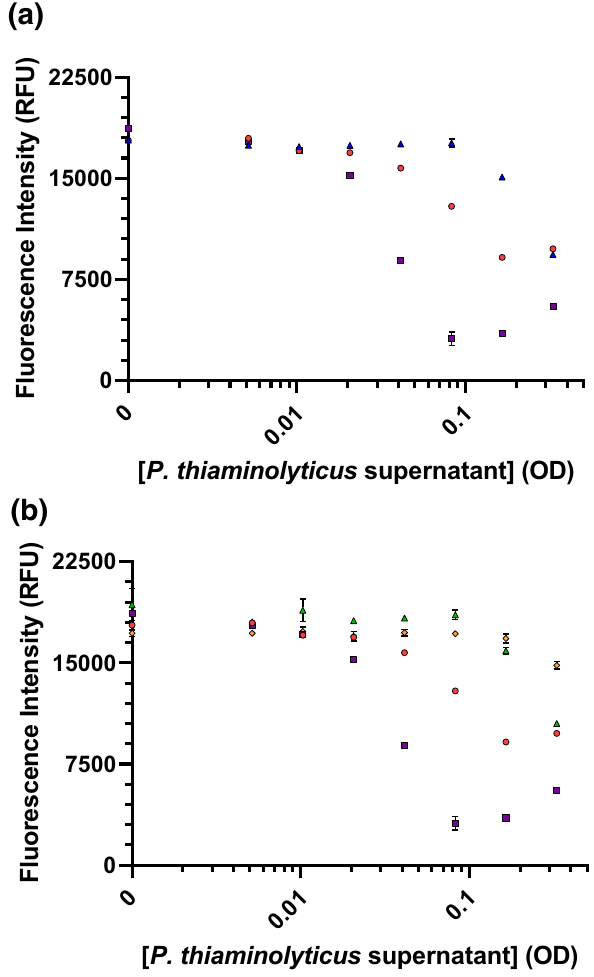
Figure 9. ( a ) Enhancement of P. thiaminoyticus thiaminase I-mediated thiamine degradation in the presence of 100 µM pyridoxine (purple squares) and 100 µM nicotinic acid (red circles) in tryptic soy broth versus tryptic soy broth alone (blue triangles). ( b ) Inhibition of P. thiaminoyticus thiaminase I-mediated thiamine degradation in the presence of 100 µM CuCl 2 and 100 µM pyridoxine (green triangles) or 100 µM nicotinic acid (orange diamonds). Fluorescence intensity measurements were made in the presence of 10 µM thiamine, 100 µM pyridoxine or 100 µM nicotinic acid and 0–100 µM Cu 2+ in the presence of crude P. thiaminolyticus supernatants in TSB at 37 °C for 1 h, as described in the “Materials and methods” section. The x-axis corresponds to dilutions of the supernatant from the OD measured of the bacteria at the time of supernatant collection. Each point is the average of the fluorescence values with error bars representing the standard deviation of triplicate